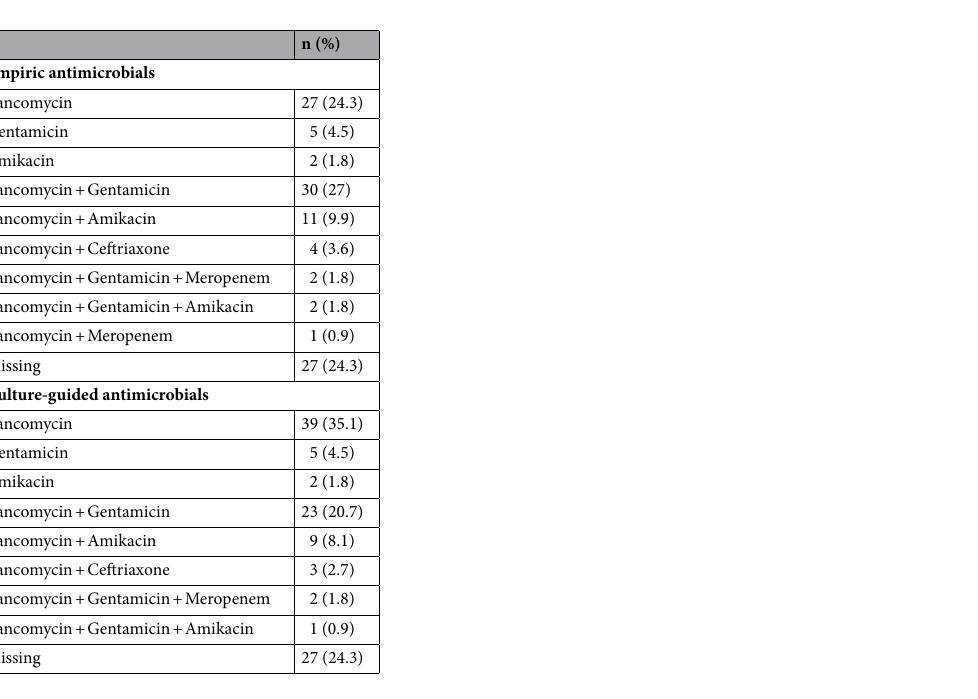
Table 4. Frequency and percentages of empiric and culture-guided antimicrobials used.